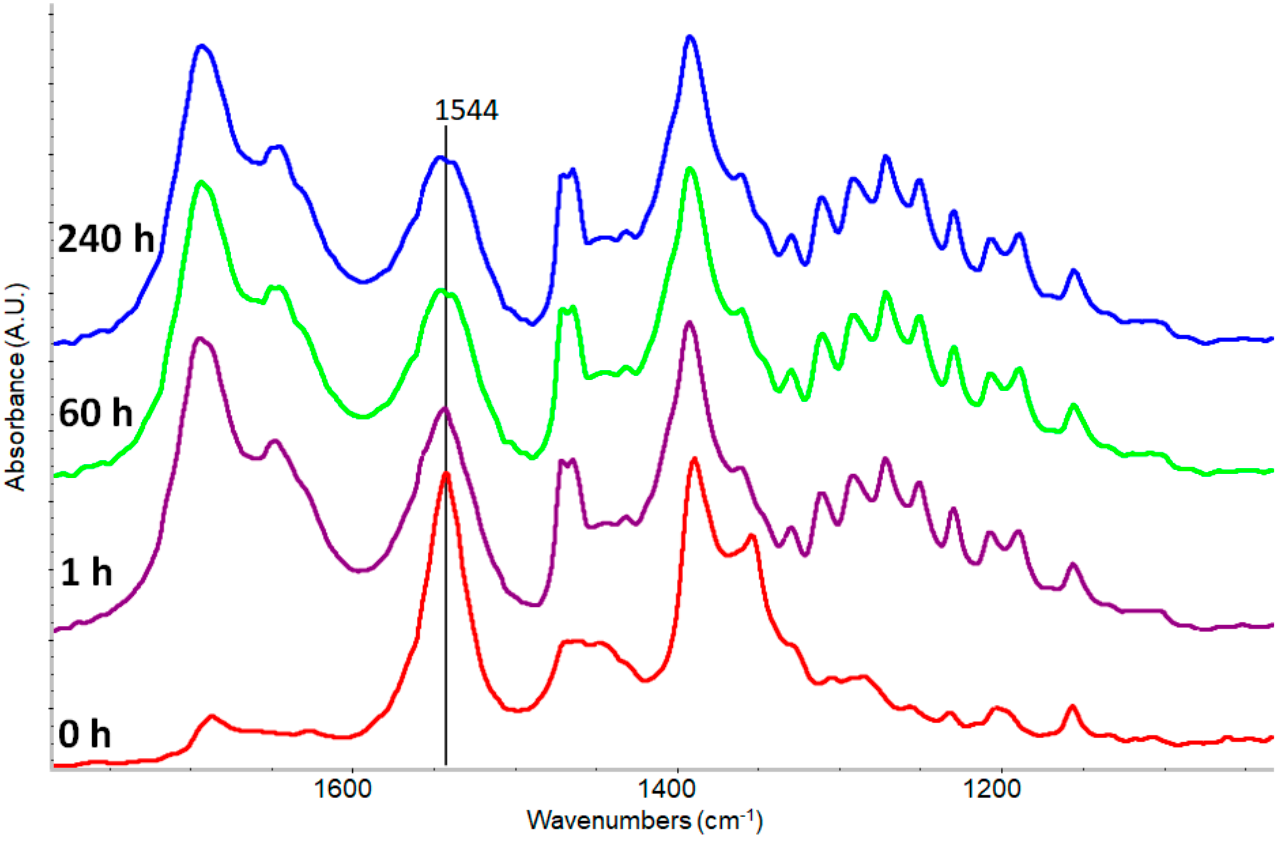
Figure 6. Kinetics of potassium abietate mixed with fresh added palmitic acid in the spectral range from 1100 to 1800 cm − 1 . Before the mixing (red line), after 1 h (violet line), after 60 h (green line) and after 240 h (blue line).